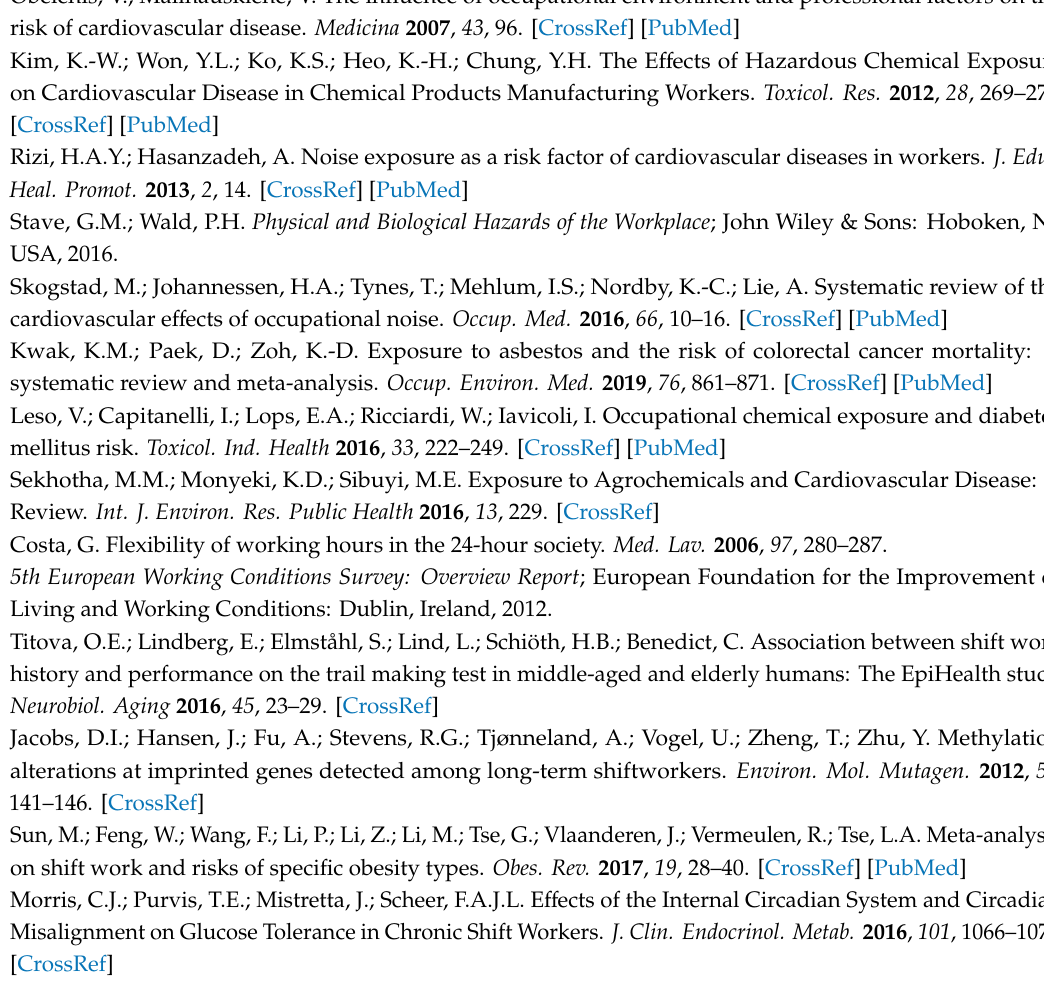
Table S1. Number and percentage of missing values for outcome variables. Table S2. Prevalence ratio of workplace hazards among shift workers compared to other workers (reference). Sensitivity analyses. Table S3. Prevalence ratio of workplace hazards after 1980 compared to before 1980 (reference). Sensitivity analyses. (https: // www.ukbiobank.ac.uk /